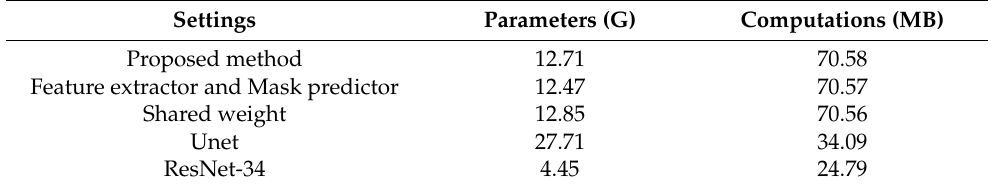
Figure 13. Ablation experiments. Feature extractor and mask predictor [15] and w/o. Shared weight are ablation experiments for shallow feature extraction networks. Unet [38] and ResNet-34 [39] are ablation experiments on generator backbones. Table 3. Comparison of the number of parameters and computations under different ablation settings.